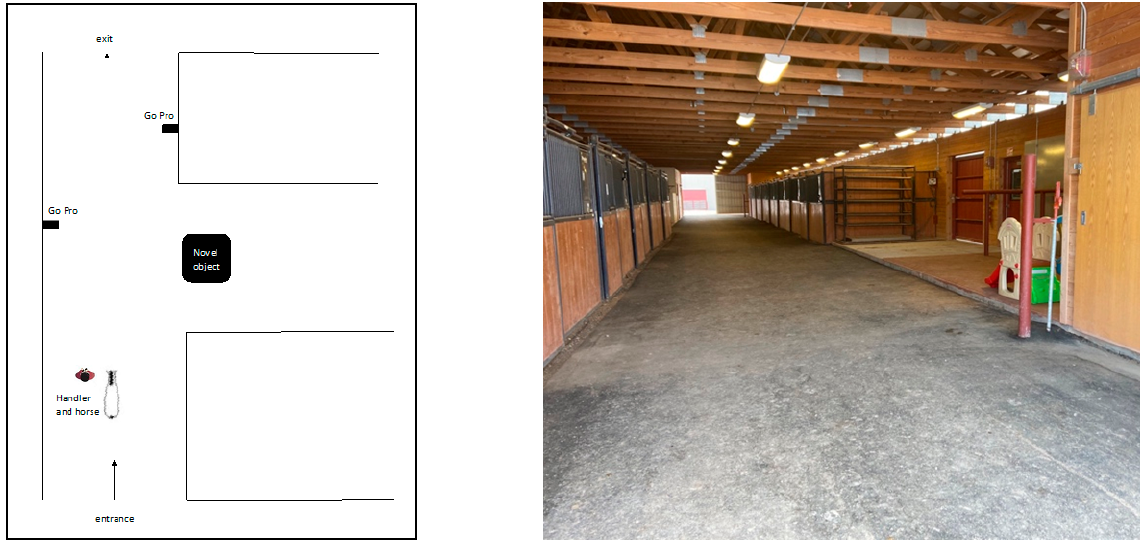
Figure 1. The test area consisted of GoPros ( ) and the novel object placed during habituation to the novel object and rotation days.